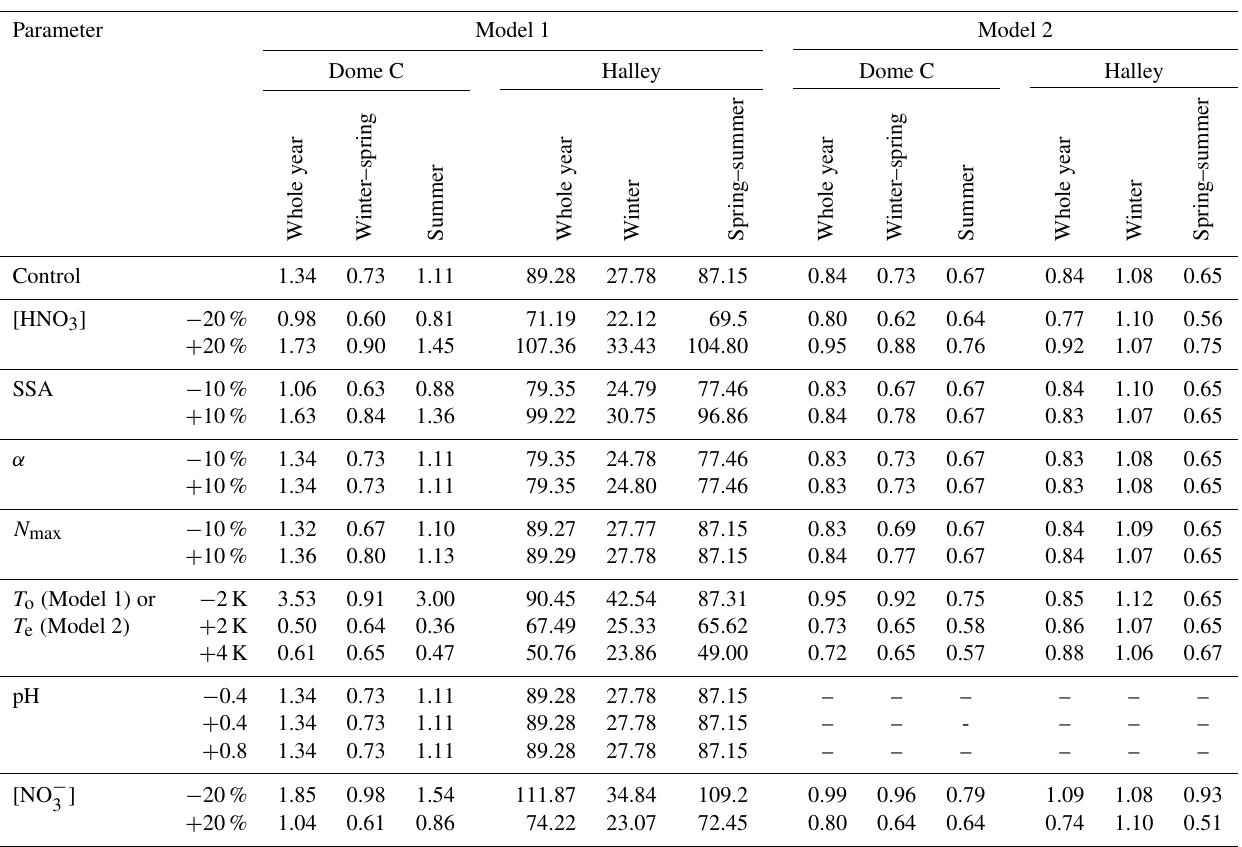
Table 4. Sensitivity test for Model 1 and 2 based on the coefficient of variation of RMSE, C v (RMSE); the metric was used to measure a goodness of fit. Note that column one is not fitted to the observation and the values are only varying to show the sensitivity of the models against inputs and